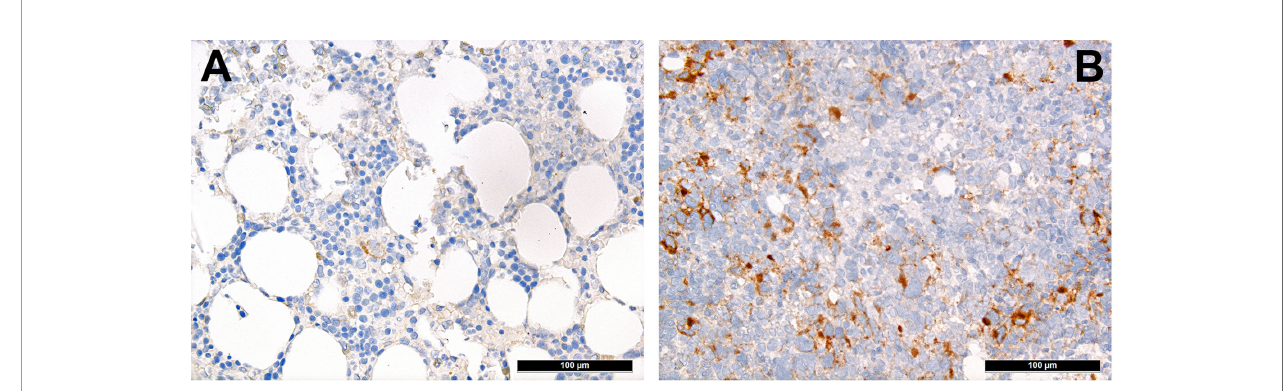
FIGURE 3 | Distribution of PD-L1+ mononuclear tumor-in fi ltrating cells in AML. Case of relapsing AML showing high expression of PD-L1 (B) in contrast to very scarce expression of PD-L1 in the adjacent non-neoplastic bone marrow ( A ;